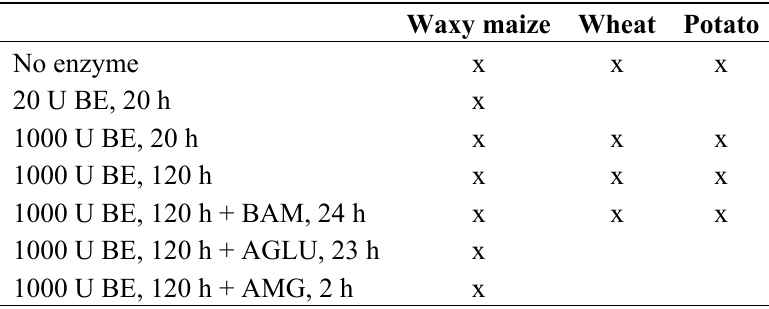
Table 5. Overview of experimental